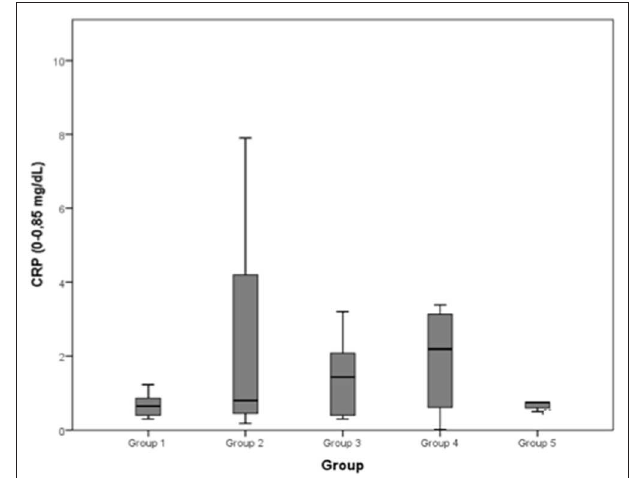
FIGURE 8 | C-reactive protein (CRP) (0–0.85 mg/dL): no differences between the five examined groups were detected. 16332.8/mm 3 in group 2, of 11096.7/mm 3 in group 3, of 7536.9/mm 3 in group 4, of 9132.1/mm 3 in group 5,